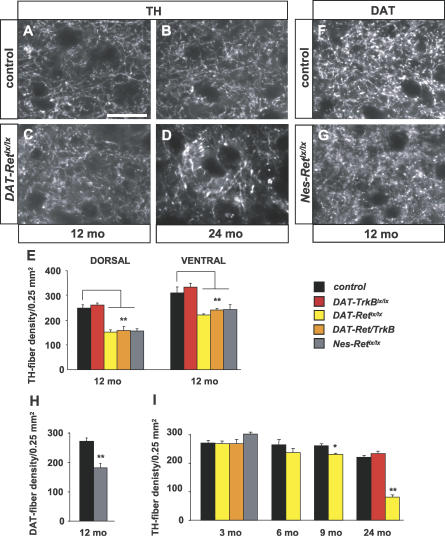
Progressive Loss of Striatal Innervation in DAT-Retlx/lx, but Not DAT-TrkBlx/lx Mice(A–D, F, and G) Representative images of dorsal striatum stained by immunofluorescence using antibodies against TH (A–D) and DAT (F and G) of control (A, B, and F) and DAT-Retlx/lx mutants (C, D, and G) at 12 (A, C, F, and G) and 24 mo of age (B and D).(E) The innervation density based on anti-TH immunofluorescence was quantified in dorsal versus ventral striatum of 12-mo-old controls (n = 16) versus DAT-TrkBlx/lx (n = 4), DAT-Retlx/lx (n = 6), double DAT-Ret/TrkB (n = 5), and Nes-Retlx/lx mutants (n = 7). DAT-Retlx/lx, double DAT-Ret/TrkB, and Nes-Retlx/lx mutants showed significant reductions in TH fiber density in dorsal (p < 0.001) and ventral striatum (p < 0.001, p < 0.01, and p < 0.01 for DAT-Retlx/lx, double DAT-Ret/TrkB, and Nes-Retlx/lx mutants, respectively). **, p < 0.01 (Student t-test).(H) The innervation density based on anti-DAT immunofluorescence was quantified in 12-mo-old Nes-Retlx/lx mutants compared to age-matched controls (n = 4 per genotype; p < 0.001, Student t-test).(I) Time course of TH-positive fiber loss from 3 to 24 mo of age. DAT-Retlx/lx mutant mice show a progressive fiber loss, starting at 6 to 9 mo (p = 0.09 and p < 0.05 at 6 mo and 9 mo, respectively) and maximizing at 24 mo (p < 0.0001). DAT-TrkBlx/lx mutant mice do not show any signs of fiber loss even at 24 mo of age (p = 0.13). *, p < 0.05; **, p < 0.01 (Student t-test). Scale bar indicates 25 μm.